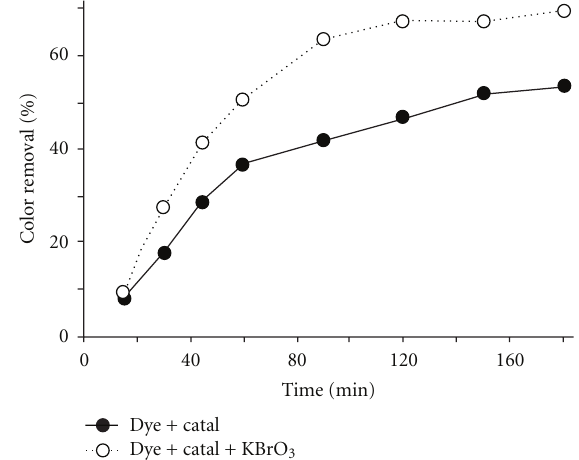
Figure 8: pH dependence of methyl green decolorization in irradi- ated solutions [methyl green] 0 = 40mgL − 1 , [Fe-OP-NCY] = 1gL − 1 , T = 25 ◦ C.